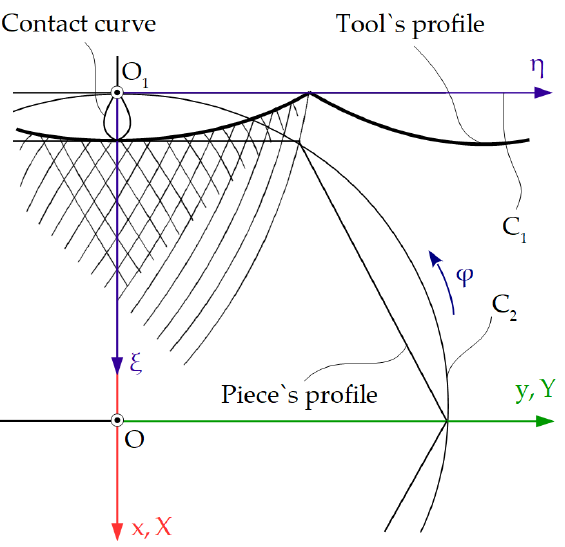
Figure 6. Tool’s profile and the in-plane trajectories of piece [12].